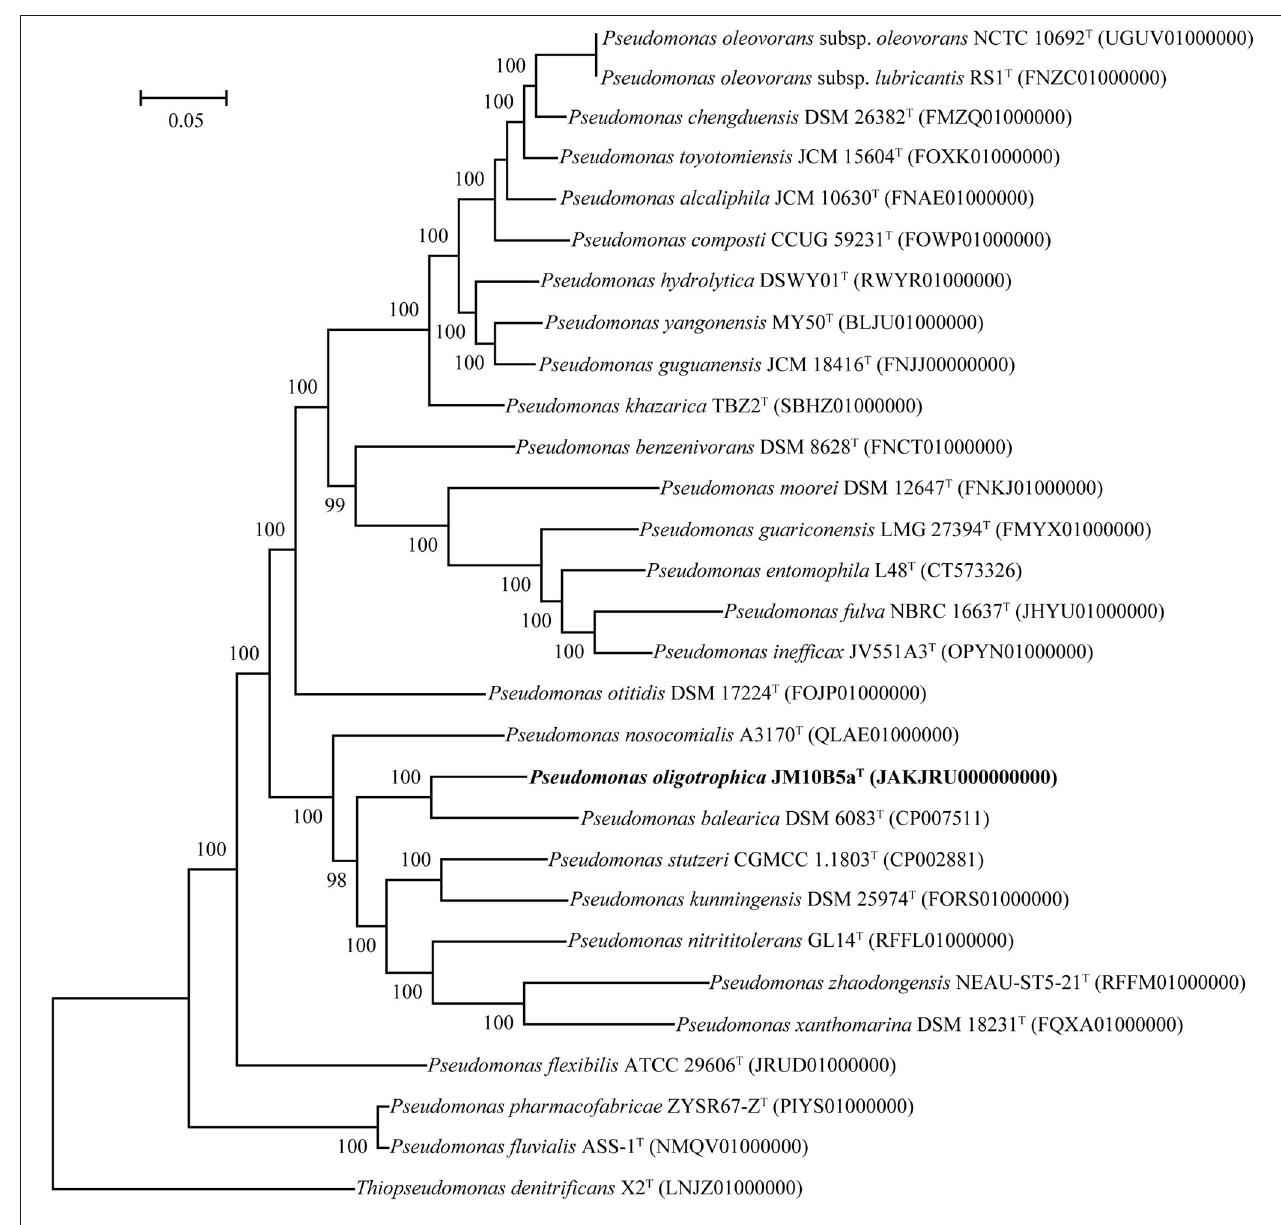
FIGURE 2 | Phylogenomic tree based on 92 bacterial core gene sets of strain JM10B5a T and the related type strains of genus Pseudomonas . Type strain Thiopseudomonas denitrificans X2 T was used as an outgroup. Bootstrap values higher than 70% were shown at branch points. Bar, 0.05 represents the number of substations per